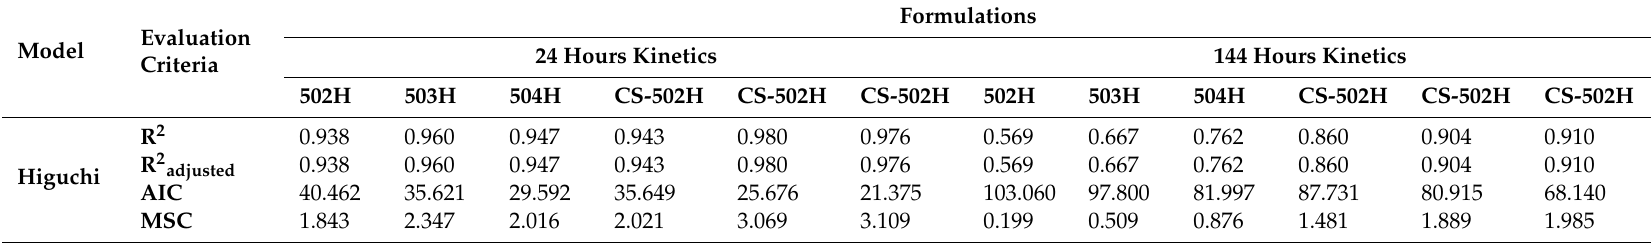
Table 3. Kinetic results for Higuchi Model.